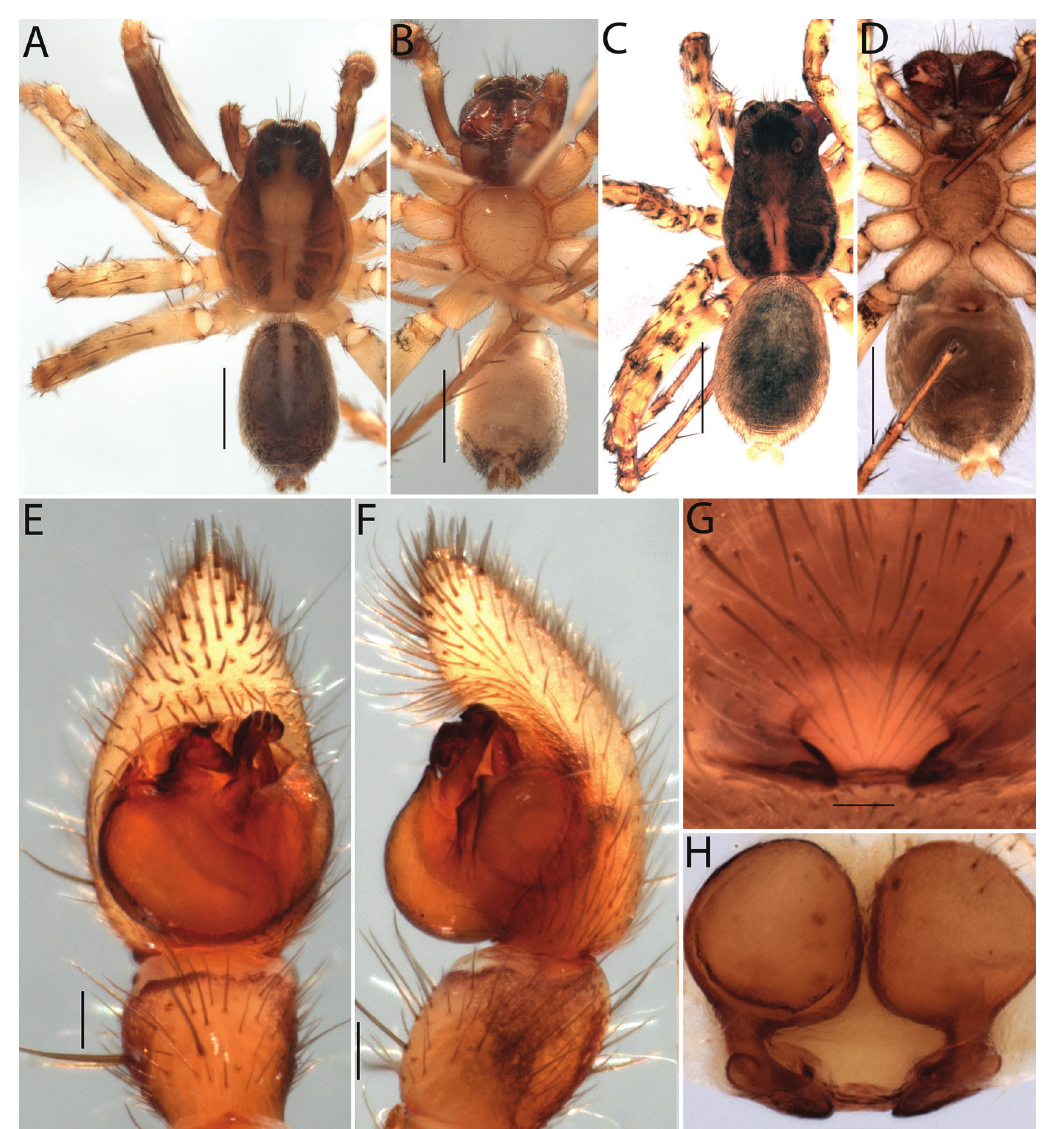
Figure 45. Artoria wilkiei sp. n., male holotype (AM KS128072), female paratype (AM KS63496): A , male habitus, dorsal view; B , male habitus, ventral view; C , female habitus, dorsal view; D , female habitus, ventral view; E, male pedipalp, ventral view; F , male pedipalp, retrolateral view; G , epigyne, ventral view; H , epigyne, dorsal view. Scale bars: habitus 1.0 mm; pedipalp, epigyne 0.1